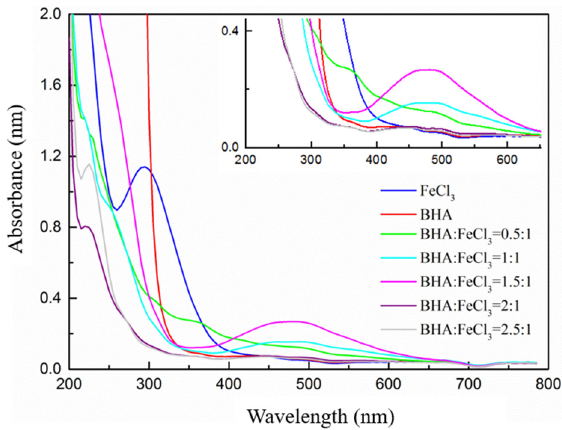
Figure 5. The UV-Vis of the FeCl 3 , BHA, and the Fe-BHA chelates with different BHA/FeCl 3 ratios.